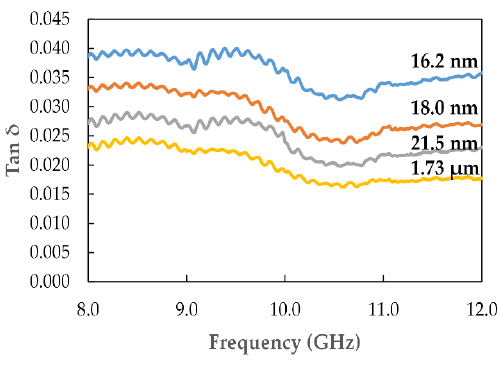
Figure 9. Variation in loss tangent with frequency for different recycled α -Fe 2 O 3 particles.